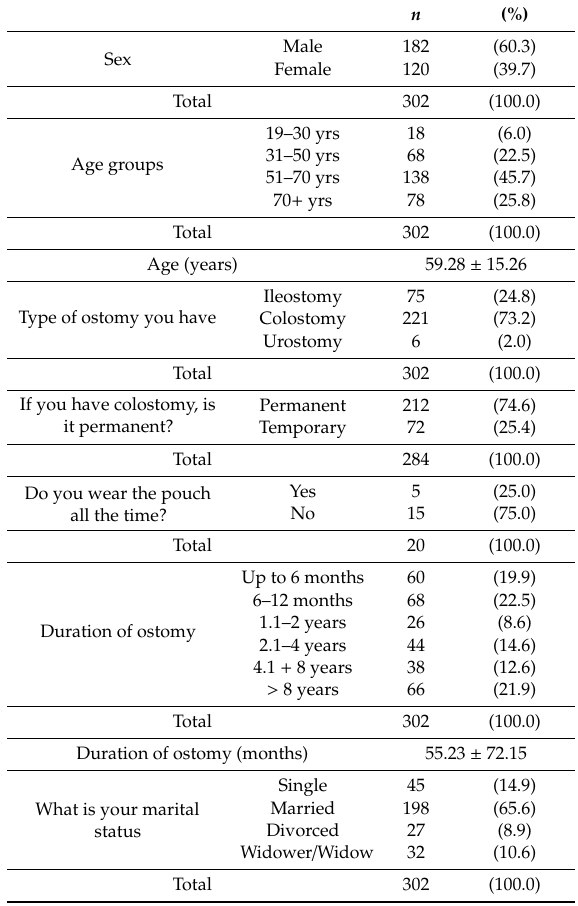
Table 1. Number and percentage of patients by sex, age, type of ostomy, duration of ostomy, and marital status, and mean and standard deviation for age and